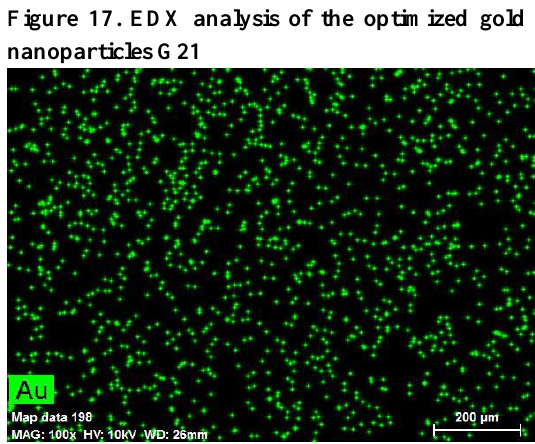
Figure 18. EDX micrograph images for metallic gold distribution of optimized gold